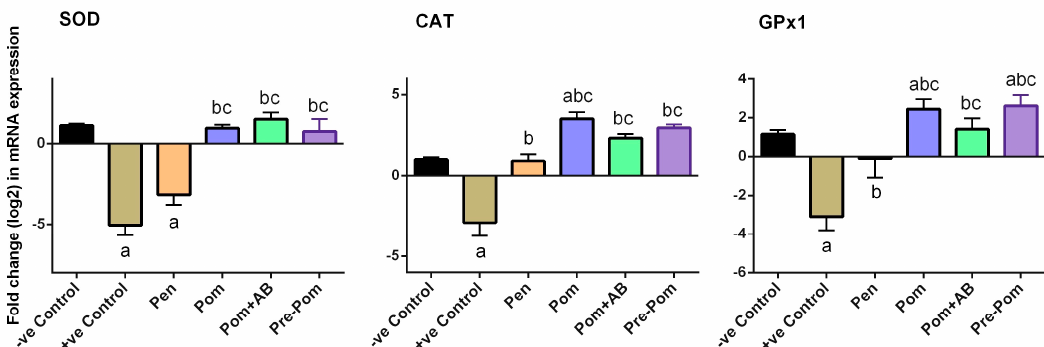
Figure 7. Effect of pomegranate juice supplementation and Pentostam treatment on dermal mRNA expression of candidate genes in the control and experimental groups. Results (mean ± SEM, n = 3) were normalized to β -actin RNA level and are shown as fold induction (in log2 scale) relative to the mRNA level in the control group. a p < 0.05, significant change compared to –ve Control group; b p < 0.05, significant change compared to +ve Control group; c p < 0.05, significant change compared to Pentostam group. SOD2: superoxide dismutase 2, CAT: catalase and GPx1: glutathione peroxidase 1.